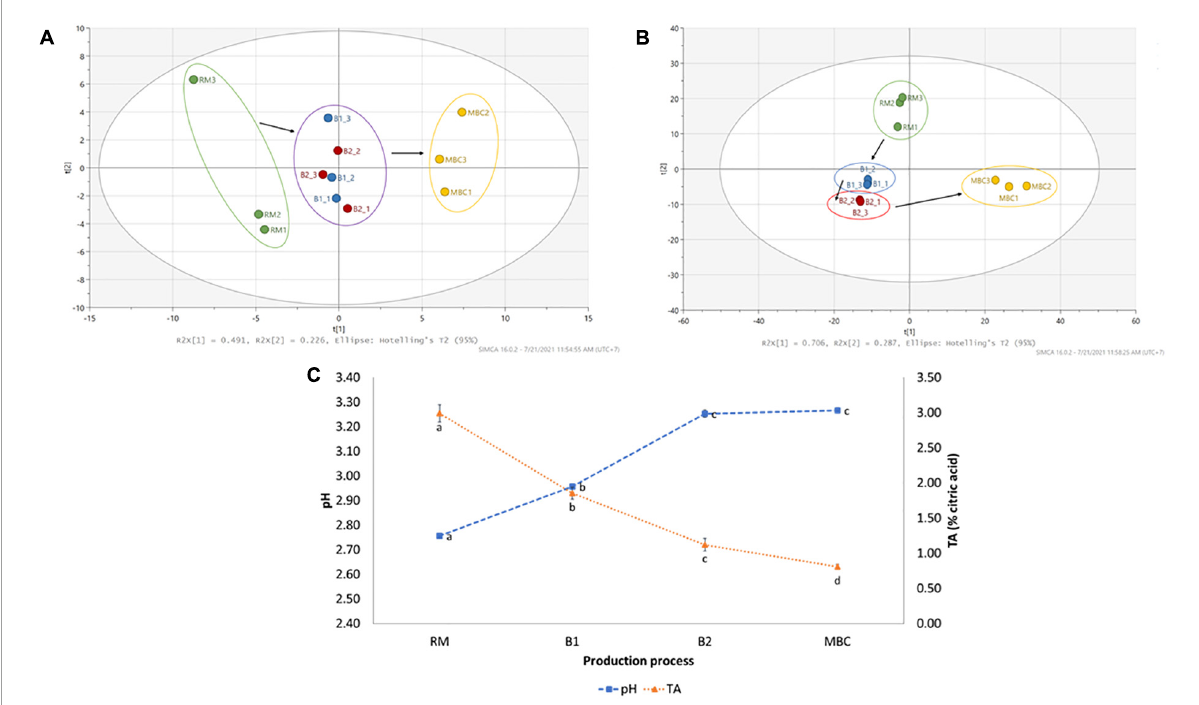
FIGURE2 PCA score plot of volatile (A) and non-volatile (B) analyses of mango flesh (RM: raw mango, B1: after brining 1, B2: after brining 2, MBC: final product) during the production process. Changes in pH and titratable acidity (TA) of mango flesh during immersion process (C) . Data of pH and TA are given as mean ± SD ( n = 3); different letter indicates a significant difference (Tukey HSD, p <